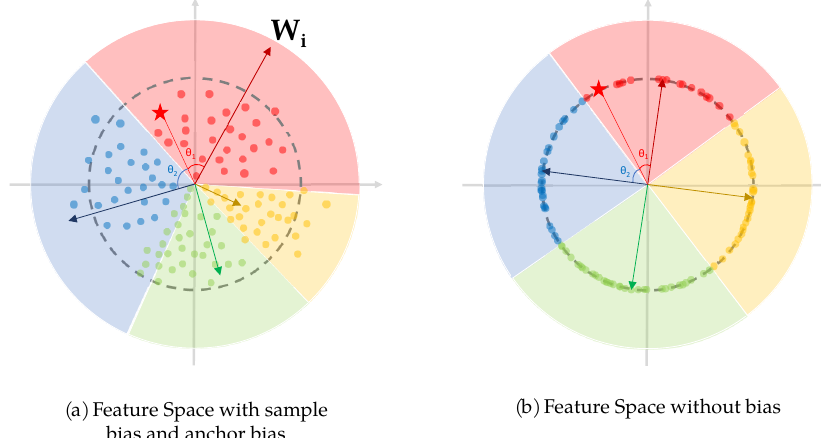
Figure 11. The feature space with and without